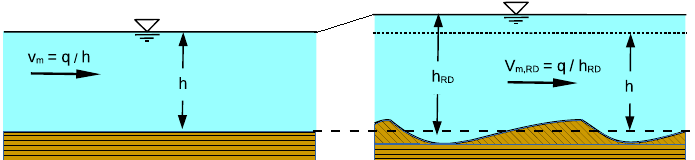
Figure 1. The effects of bedforms on hydraulics (schematically).